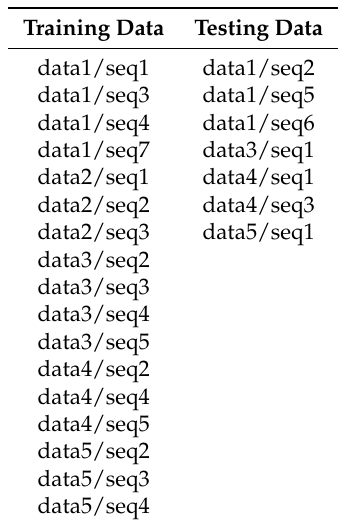
Table 1. Train and test splits of OxIOD handheld